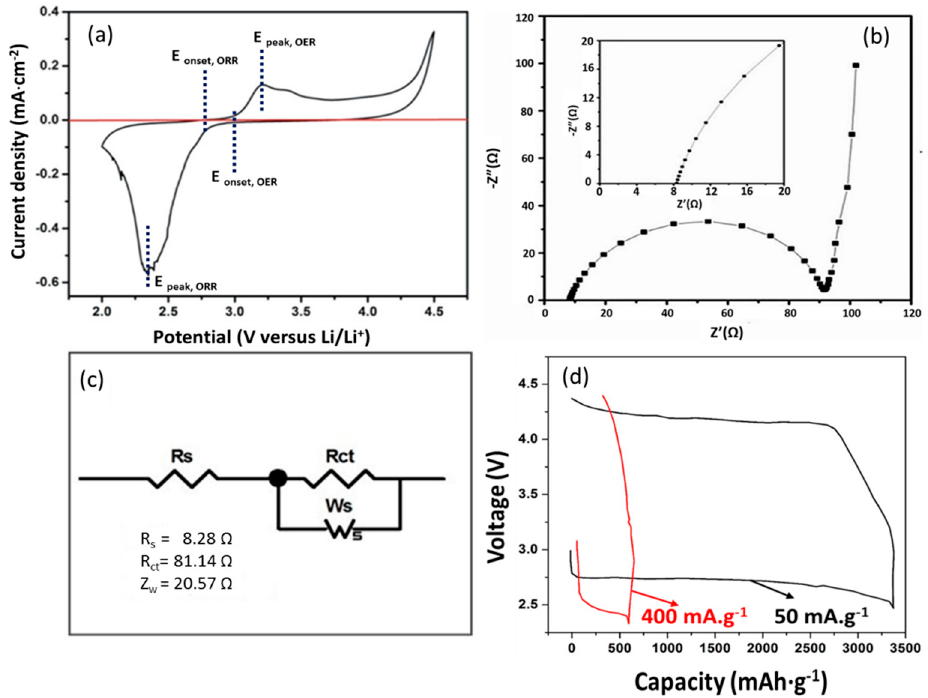
Figure 4. ( a ) The CV curve of MOHNs/KB cathode-based Li–O 2 battery with LiTFSI/TEGDME as the electrolyte; ( b ) the electrochemical impedance spectrum (EIS) of the MOHNs/KB cathode-based Li–O 2 battery. The inset is the enlarged portion of the EIS spectrum of the MOHNs/KB cathode-based Li–O 2 battery in the range of 0–20 Ω ; ( c ) the equivalent circuit model of the impedance spectrum of a MOHNs/KB cathode-based Li–O 2 battery, and ( d ) the first discharge–charge curves of the MOHNs/KB cathode-based Li–O 2 battery with the voltage between 2.4 and 4.4 V at a current density of 50 and 400 mA · g − 1 . Figure 4a,d are reproduced with permission from [16]. Copyright IEEE,